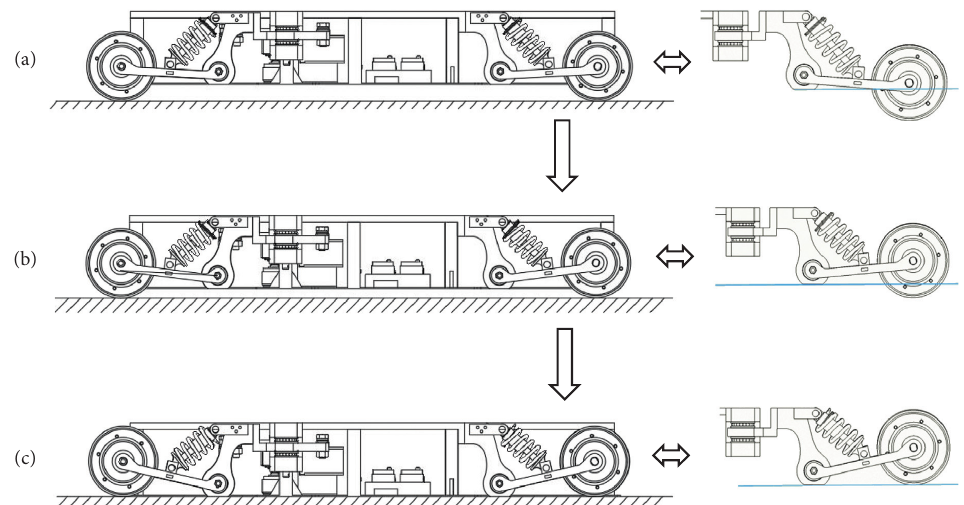
Figure 4: Working process of foldable arm suspension of testing platform vehicle: (a) no-load state, (b) working state, and (c) touchdown state.